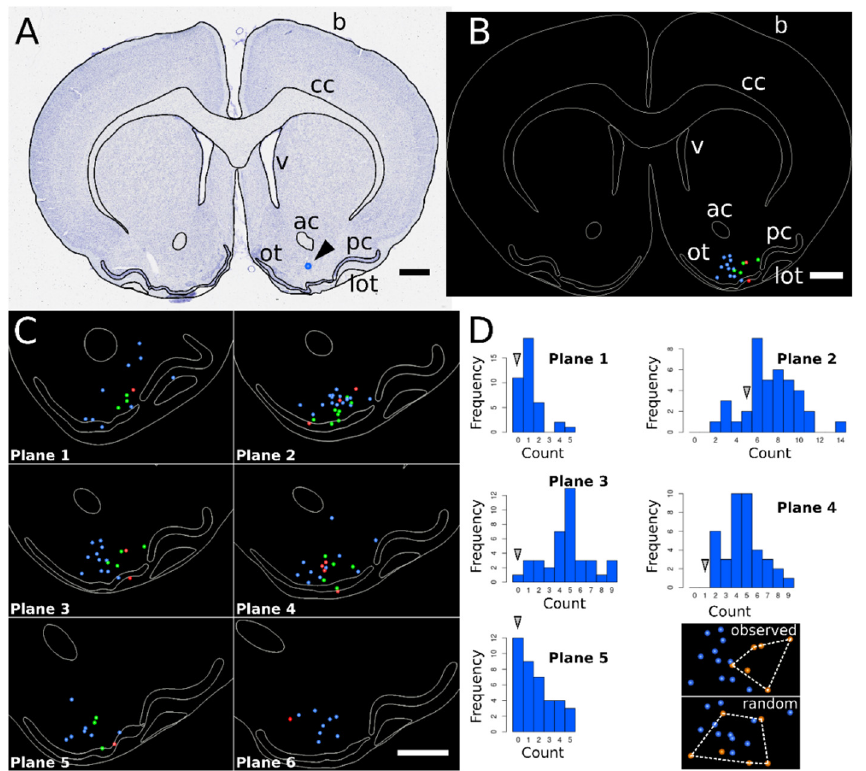
Figure 5. Spatial normalisation of brain coronal planes. ( A ): brain structures were delineated on all digitized brain coronal sections (contours in black; b: brain; cc: corpus callosum; v: ventricle; ac: anterior commissure; lot: lateral olfactory tract; pc: pyriform cortex, layer II; ot: olfactory tubercle, layer II) and recording site pointed (arrowhead). ( B ) All segmented structures except ot were used as reference structures for spatial normalisation of brain sections at each considered coronal plane. Using this normalisation procedure, the positions of recorded neurones were mapped into an average representation of the considered plane (illustration corresponding to Plane 3). Non-responsive, inhib- ited, and activated neurones are represented by blue, red, and green dots, respectively. ( C ) Enlarged portions of the ventral quadrant of six identified coronal planes, from the anterior most 1 to the posterior most 6. ( D ): quantitative analysis of the distribution of responsive neurones (red and green dots in ( C )) within the population of all recorded neurones. The number of non-responsive neurones falling inside the convex hull of responsive neurones (corresponding bin indicated by arrows, e.g., bin 0 for Plane 1) was compared to the distribution of this quantity under random assignment of responsive/non-responsive labels to neurone positions (histograms, 39 random shuffles). Scale bars: 1